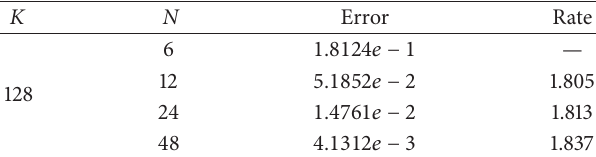
Table 1: Numerical results for Test 1.